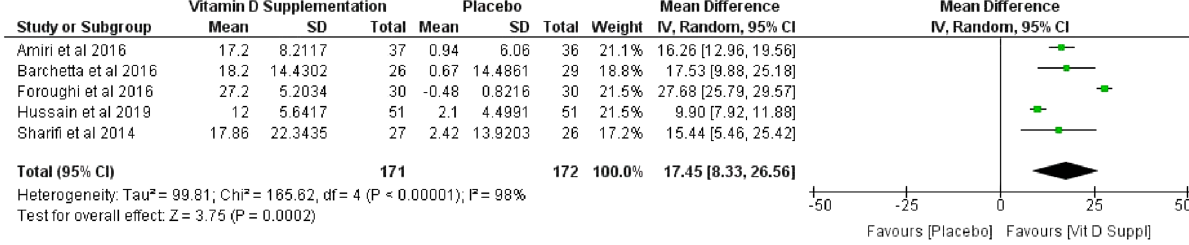
Figure 4. Forest plot of vitamin D serum.